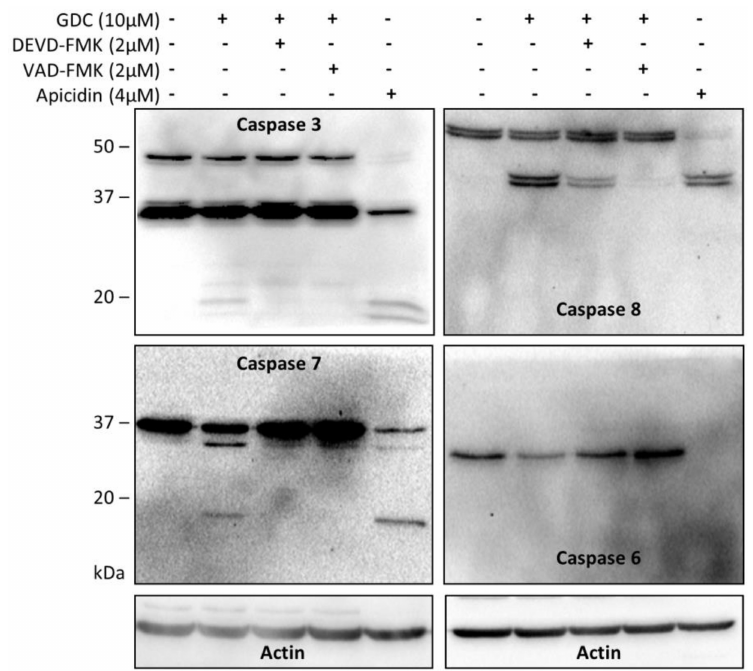
Figure 4. Effects of selected protease inhibitors on the proteolytic activation of individual caspases during GDC-0941 treatment. The proteolytic activation of caspases in control cells, cells treated with GDC-0941 for 2 h, and cells pre-treated with the Z-DEVD-FMK and Z-VAD-FMK protease inhibitors before GDC-0941 treatment was detected by immunoblotting. Cells treated with apicidin for 24 h were used as a positive